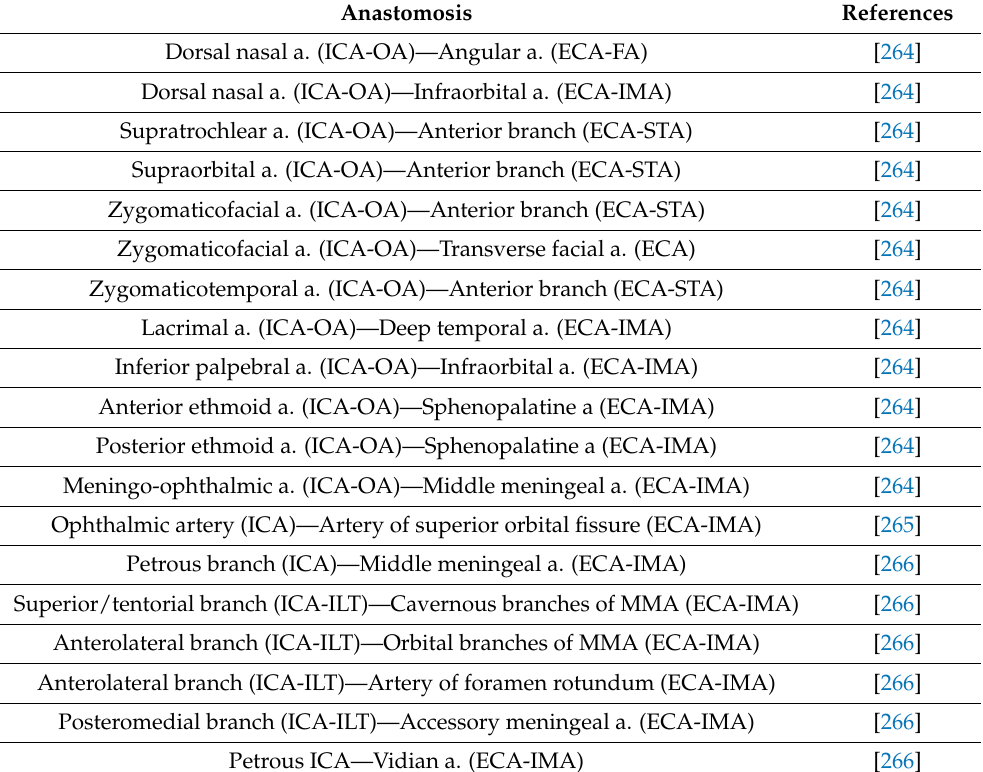
Table 4. Anastomoses between the internal and external carotid arterial systems described in the literature.